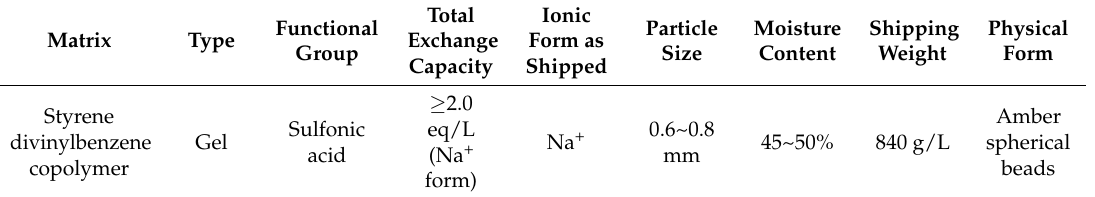
Table 1. Physical and chemical properties of ion-exchange resin (Amberlite IR 120Na).